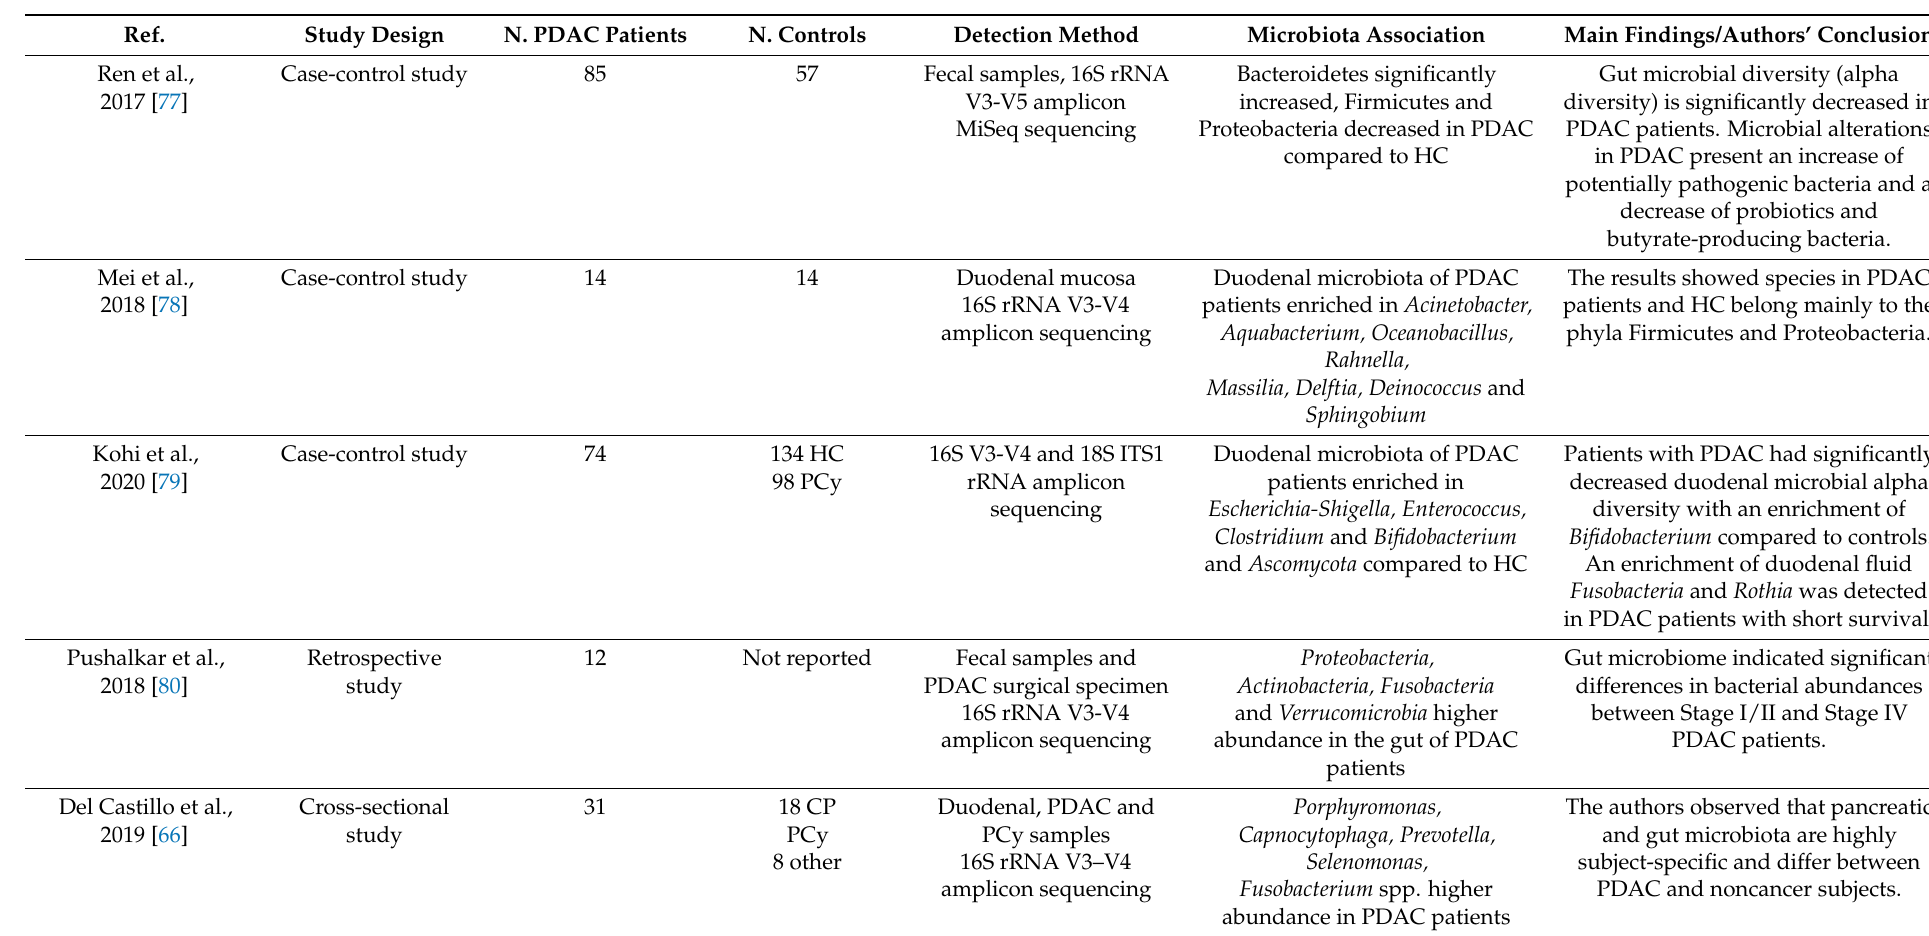
Table 3. Studies investigating the association of gut and fecal microbiota dysbiosis and PDAC. Number of subjects (N); pancreatic ductal adenocarcinoma (PDAC); healthy control (HC); chronic pancreatitis (CP); pancreatic cyst